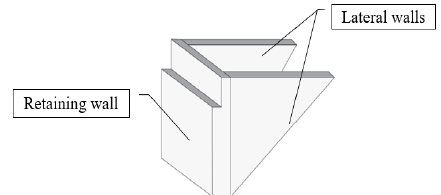
Figure 6. The main parts of the abutment